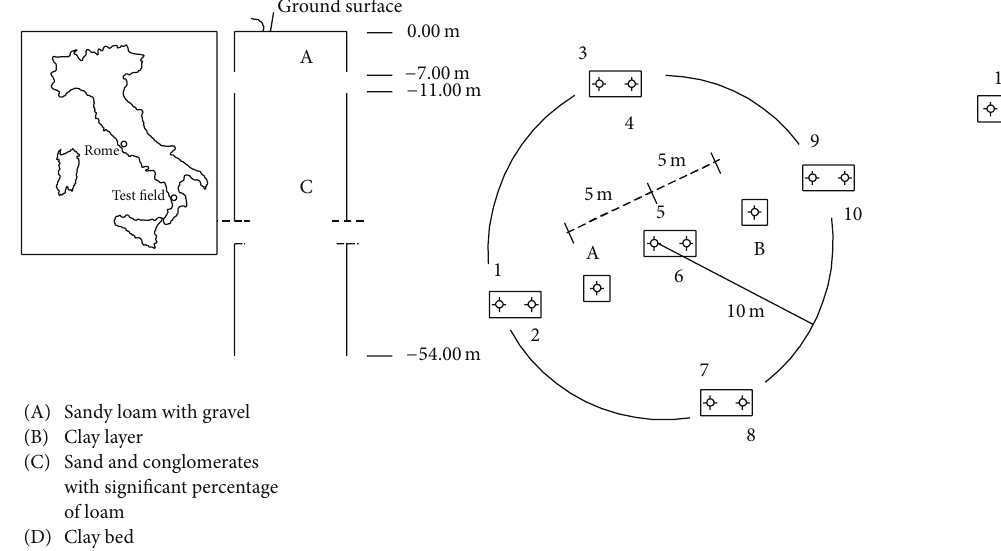
Figure 1: Stratigraphical and planimetrical layout of the test